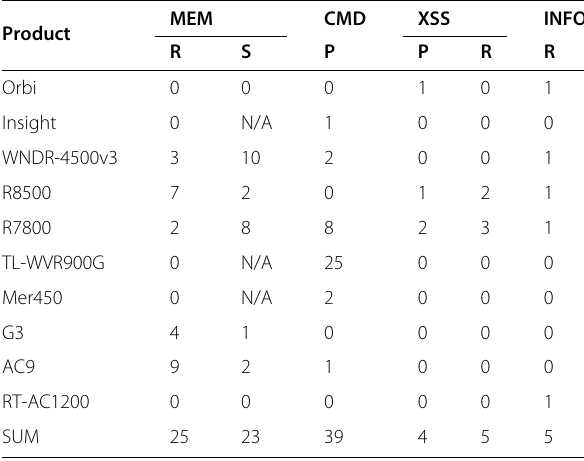
Table 6 Effectiveness of Monitors for 101 Confirmed Issues of General Mode Fuzzing